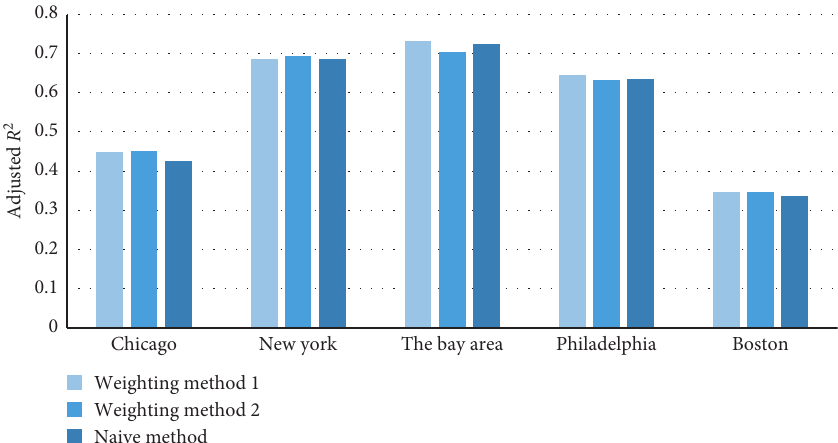
Figure 11: Negative binomial regression result of two weighting methods and the na¨ıve method.